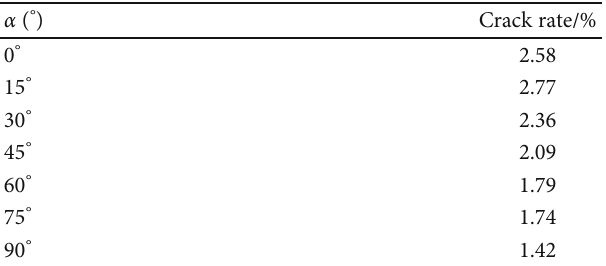
Figure 15: Fitting curve of the fractal characteristics of the damaged area at a stress level of 100% and an azimuth angle of 90 ° .